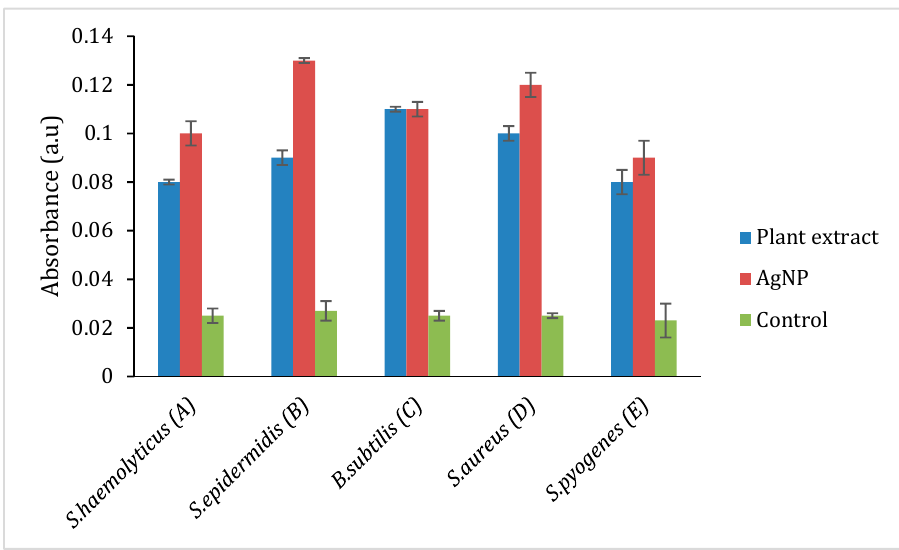
Figure 7. ROS production in selected Gram-positive bacteria. A: Staphylococcus haemolyticus, B: Staphylococcus epidermidis, C: Bacillus subtilis, D: Staphylococcus aureus, E: Streptococcus pyogenes.